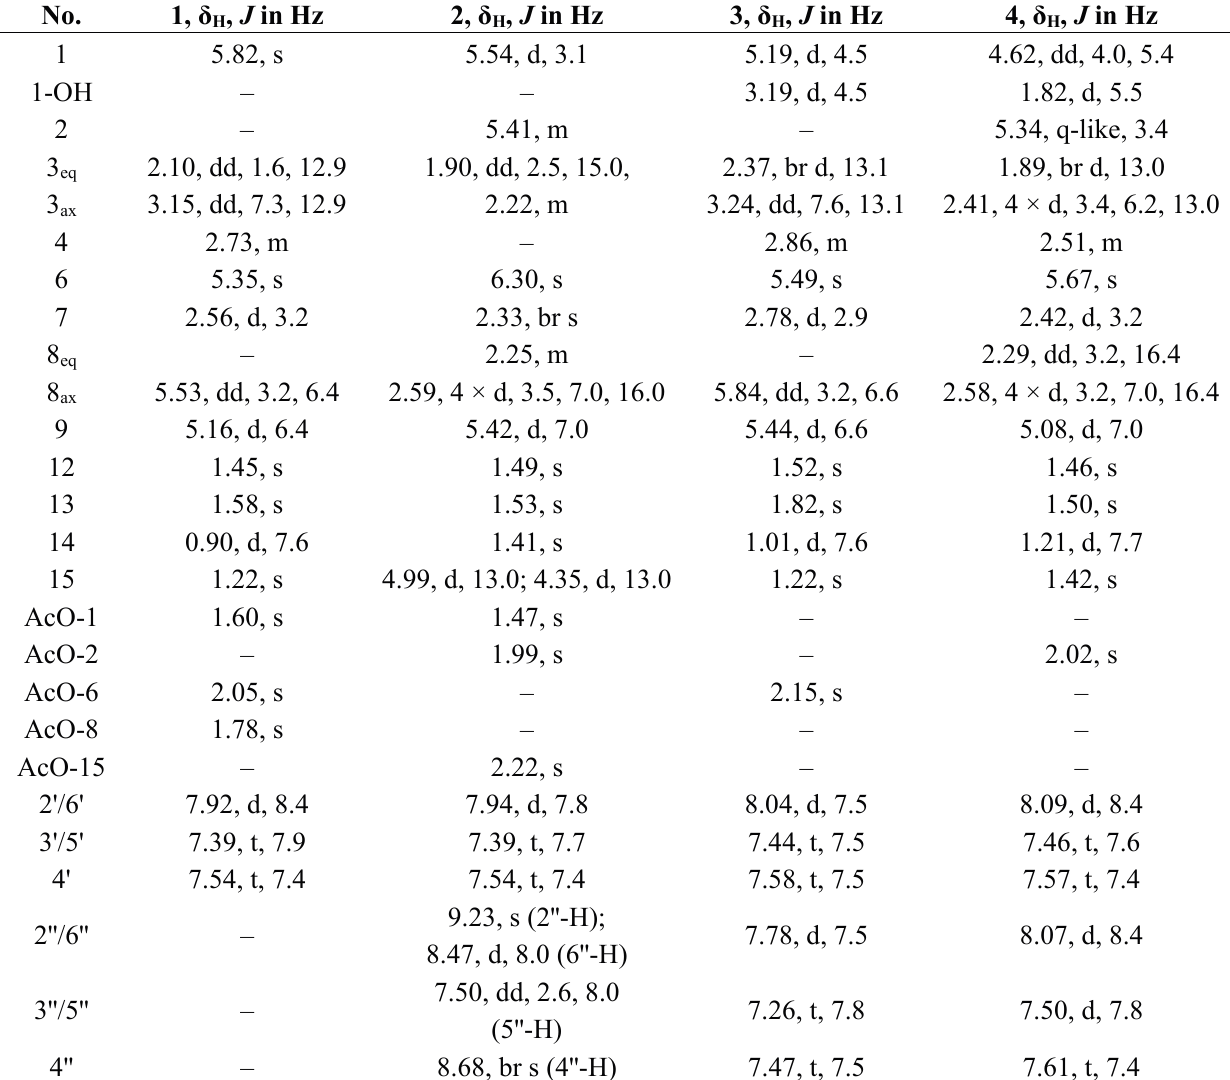
Table 1. 1 H-NMR data of compounds 1 – 4 (500 MHz; 1 and 2 : CD 3 OD; 3 and 4 : CD 3